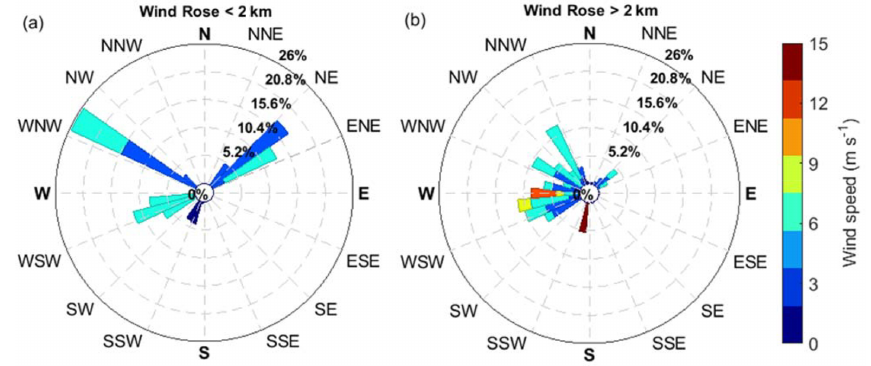
Figure 4. Wind rose (a) below 2km (8 cases) and (b) above 2km (24 cases) from radiosoundings measurements in Barcelona. The colorbar on the right applies to both